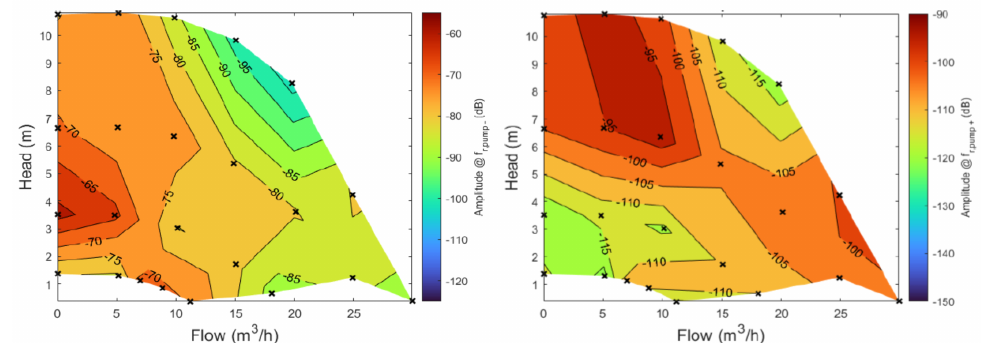
Figure 9. LoPoFIA for the fault indicators f r , pump − and f r , pump + for a pump with bearing defects on both sides (A- + B-bearing